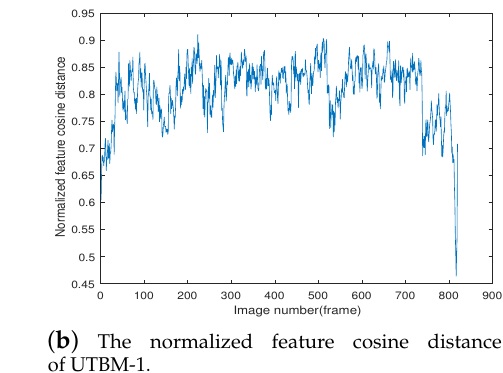
( b ) The normalized feature cosine distance of UTBM-1.